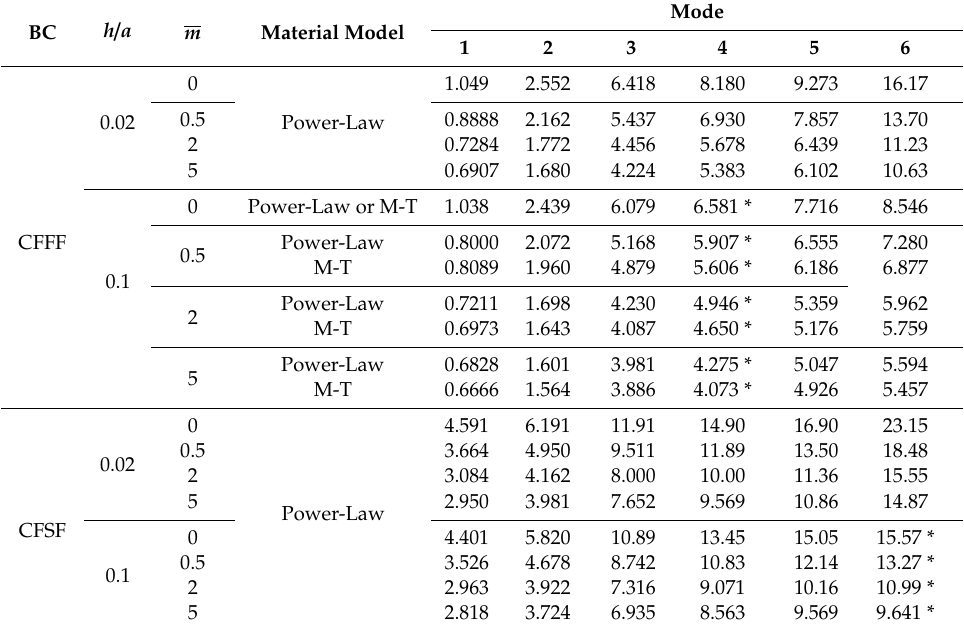
Table 9. Nondimensional natural frequencies Ω of CFFF and CFSF FGM square plates; “*” denotes the in-plane displacement-dominated mode.